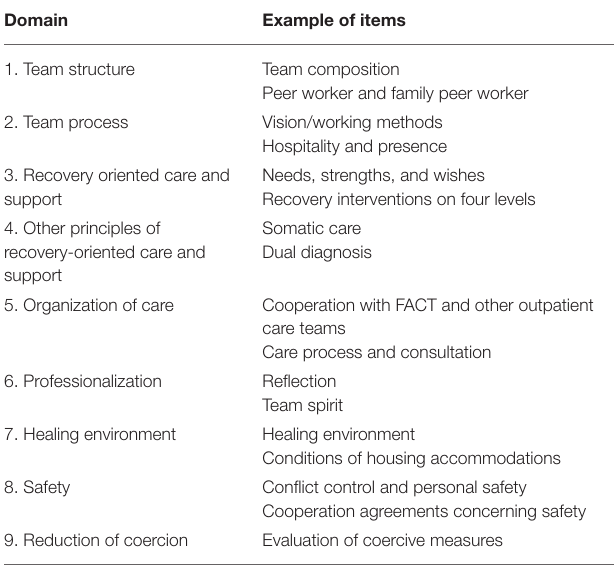
TABLE 2 | Domains of the active recovery triad (ART) monitor and examples of items.